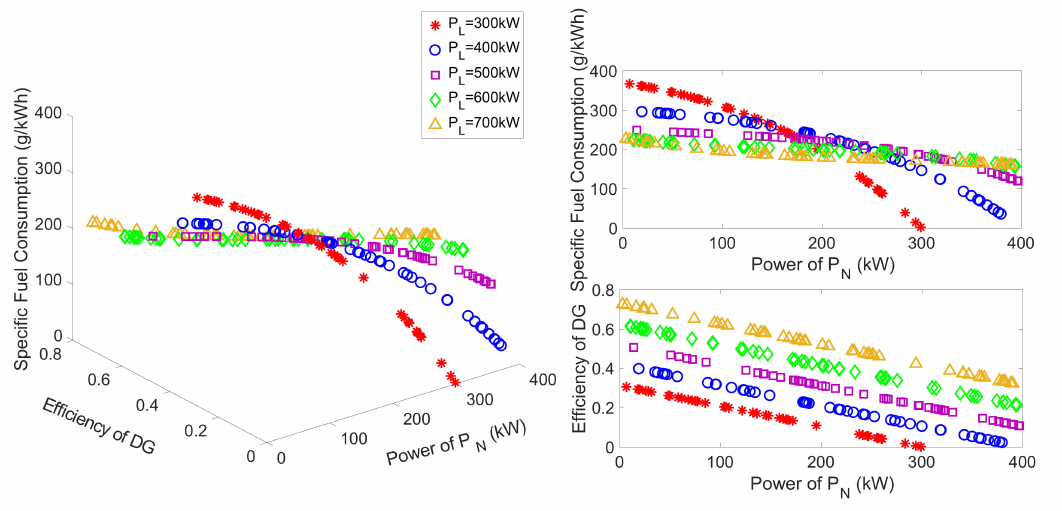
Figure 7. The distribution of non-inferior solution with P N in the range of 0–390